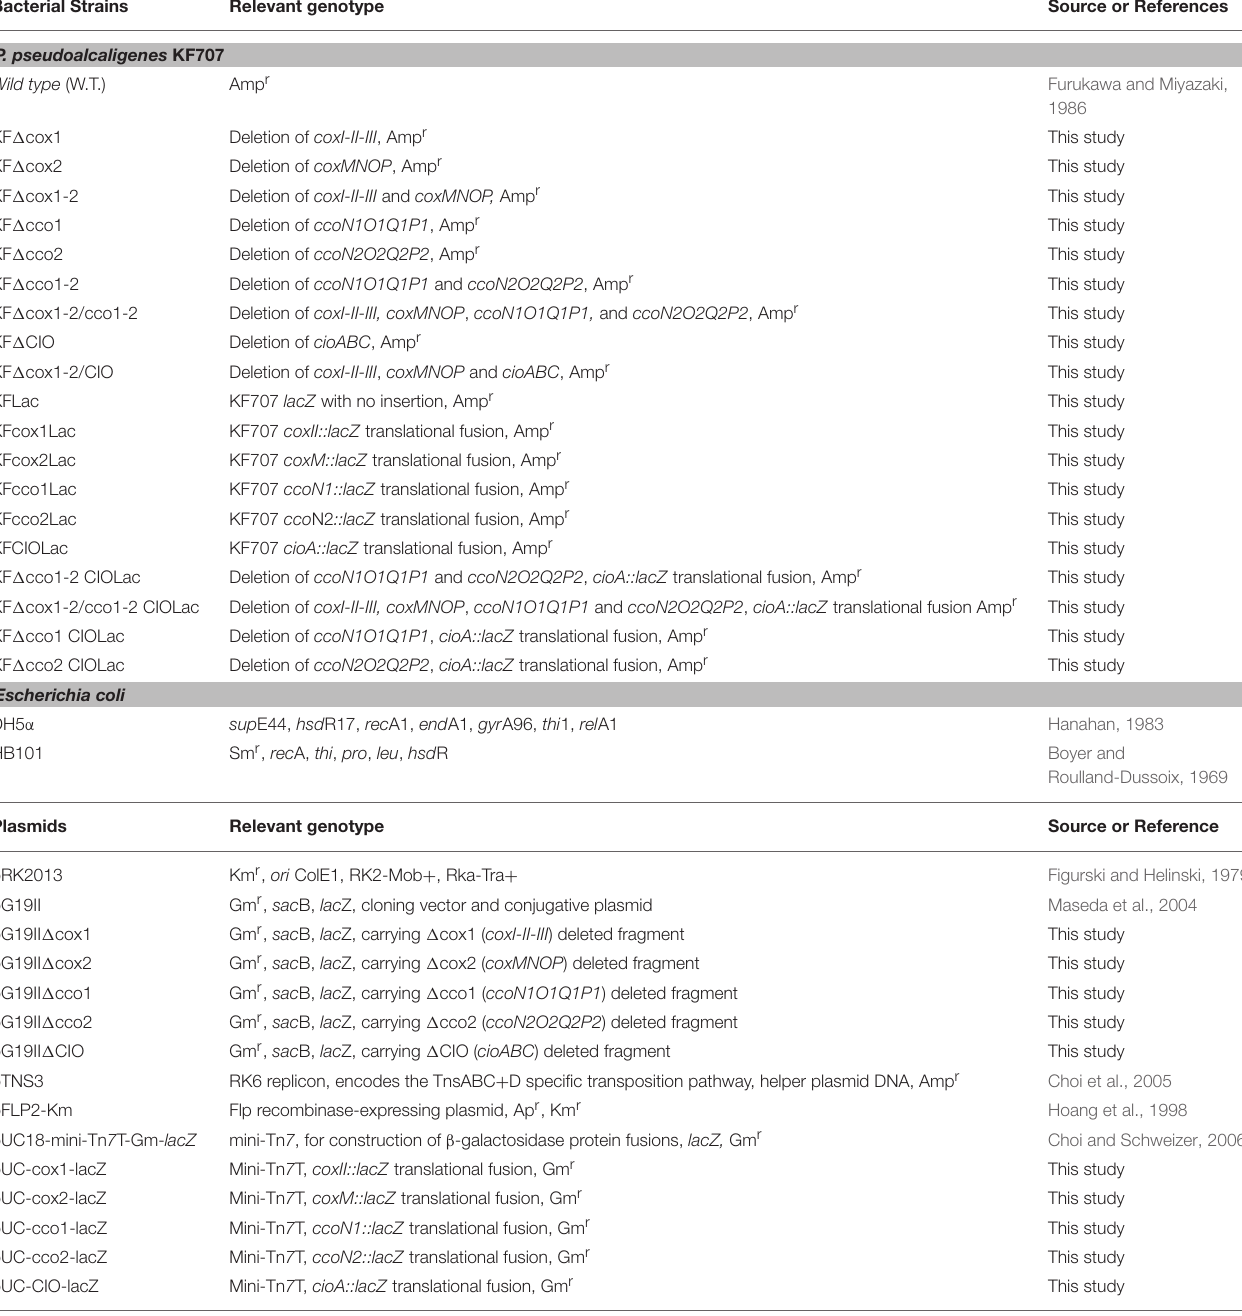
TABLE 1 | List of bacterial strains and plasmids, used in this study. Bacterial